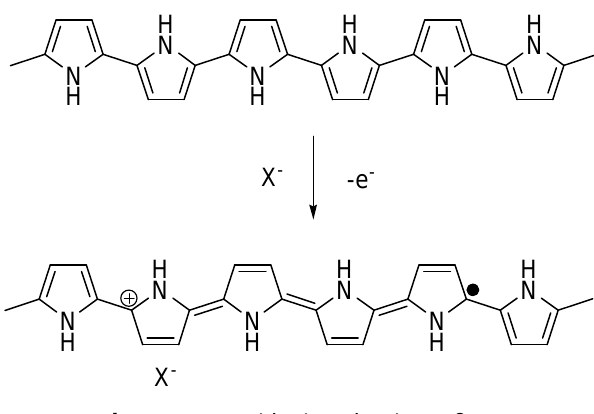
Scheme 2. Oxidation doping of